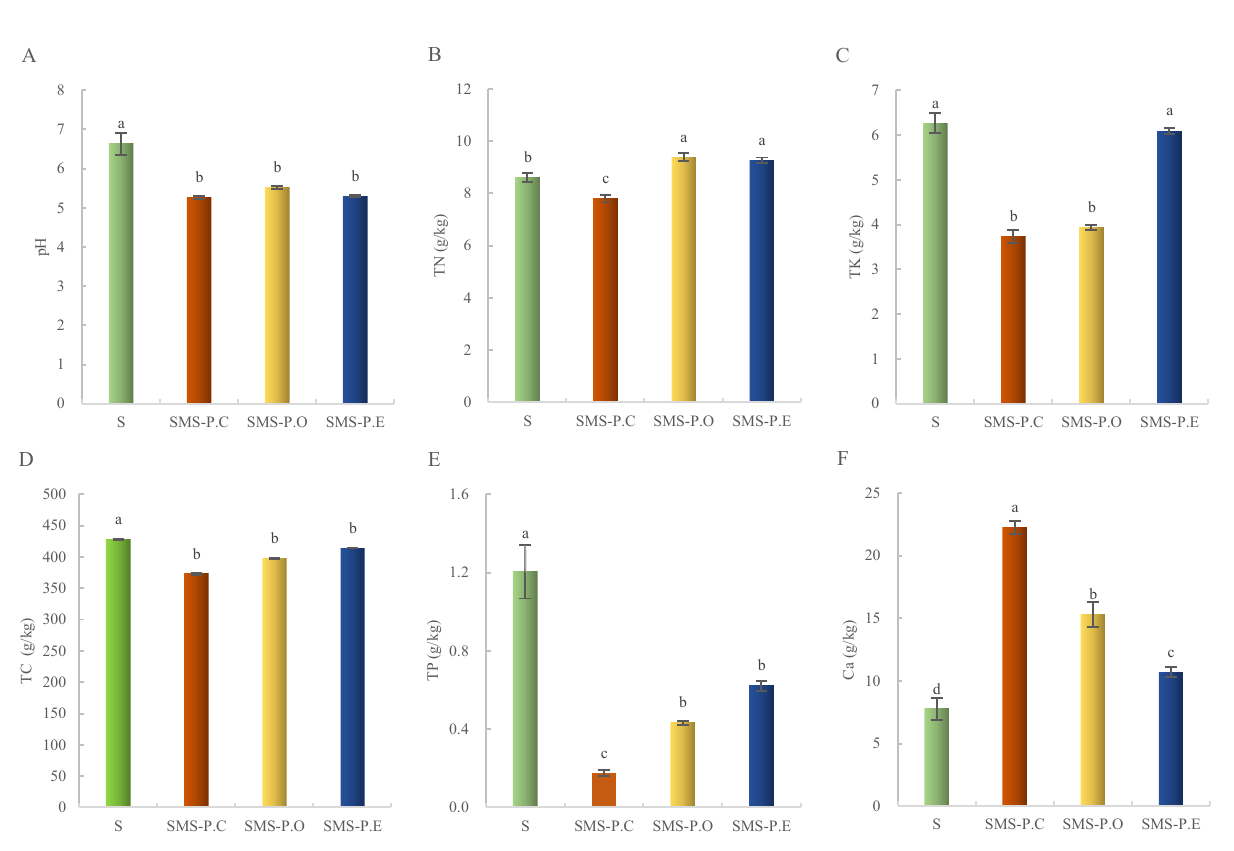
Figure 3. The pH ( A ), TN ( B ), TK ( C ), TC ( D ), TP ( E ), and Ca ( F ) in substrate and spent mushroom